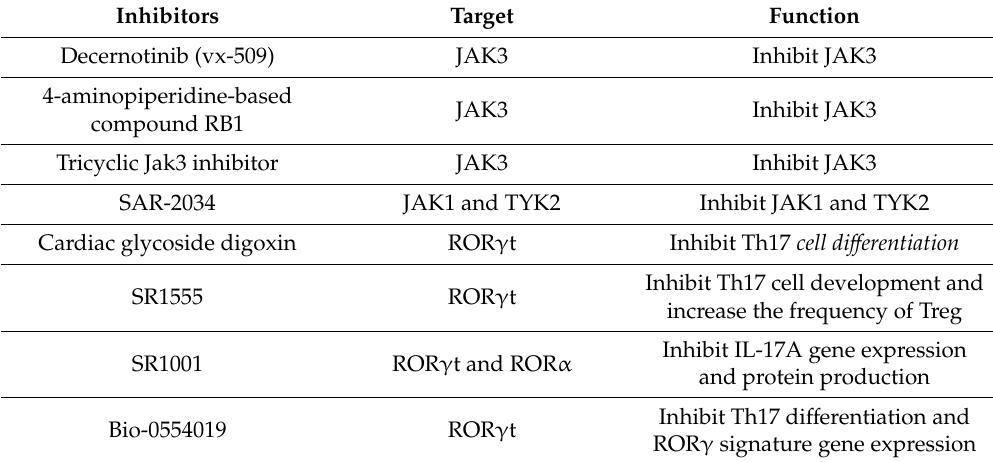
Table 1. Associated